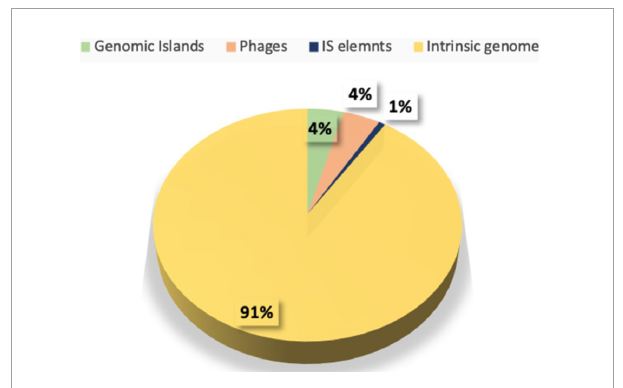
FIGURE4 Distribution of various mobile genetic elements like insertion sequences (ISs), genomic islands (GIs), phage ( (cid:56) ) elements in the genome of E. faecium LR13.